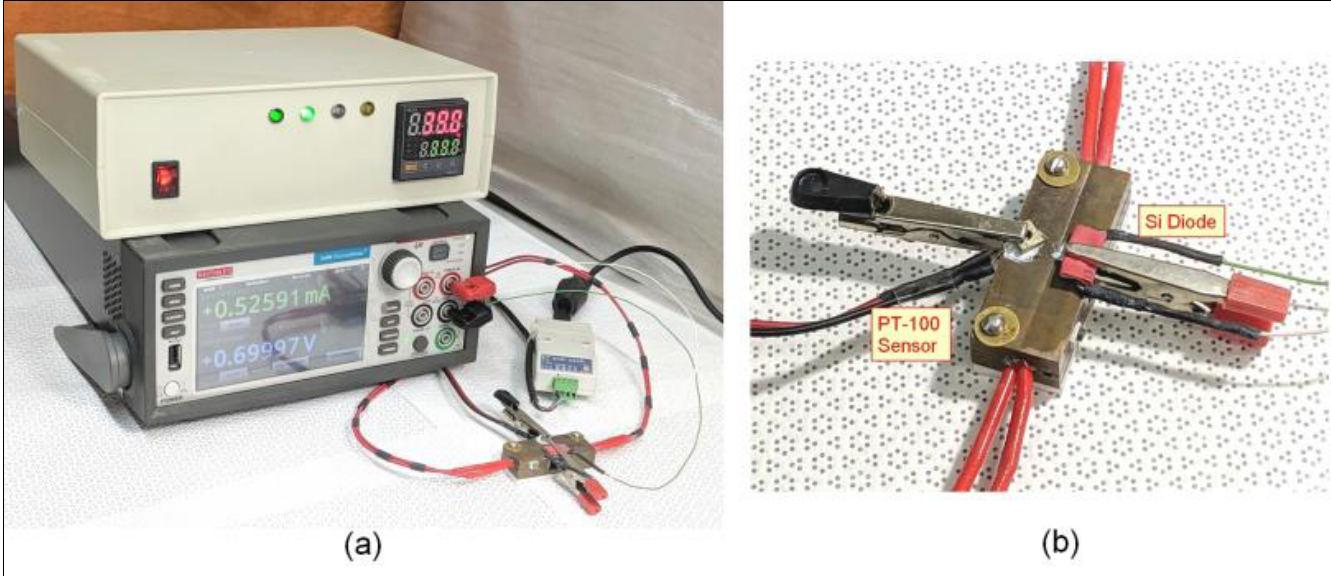
Figure 6: (a) Keithley Model-2450 Source Meter and heater power supply integrated with an Autonics TK series temperature controller connected via a USB-to-RS-485 converter. (b) View of the copper-made heating plate mounted with two cartridge heaters, one PT-100 sensor, and a common silicon diode IN-4007 as the device under test